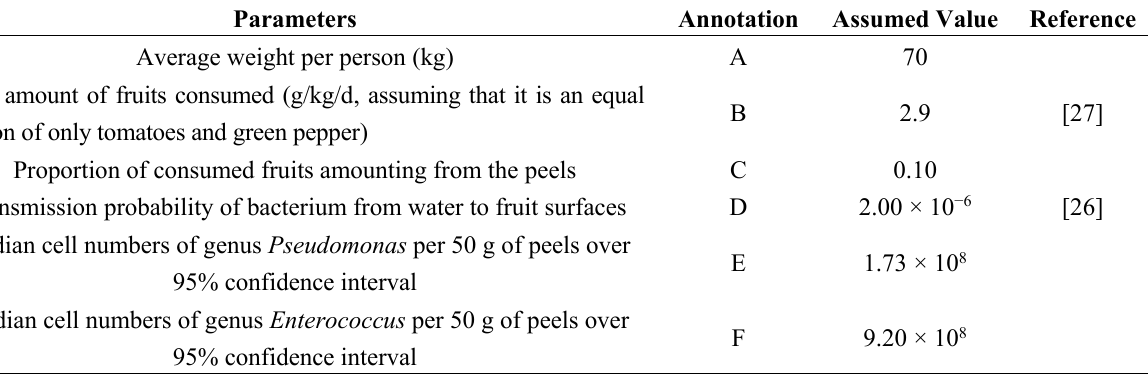
aeruginosa and Enterococcus faecalis , and the assumptions made to facilitate